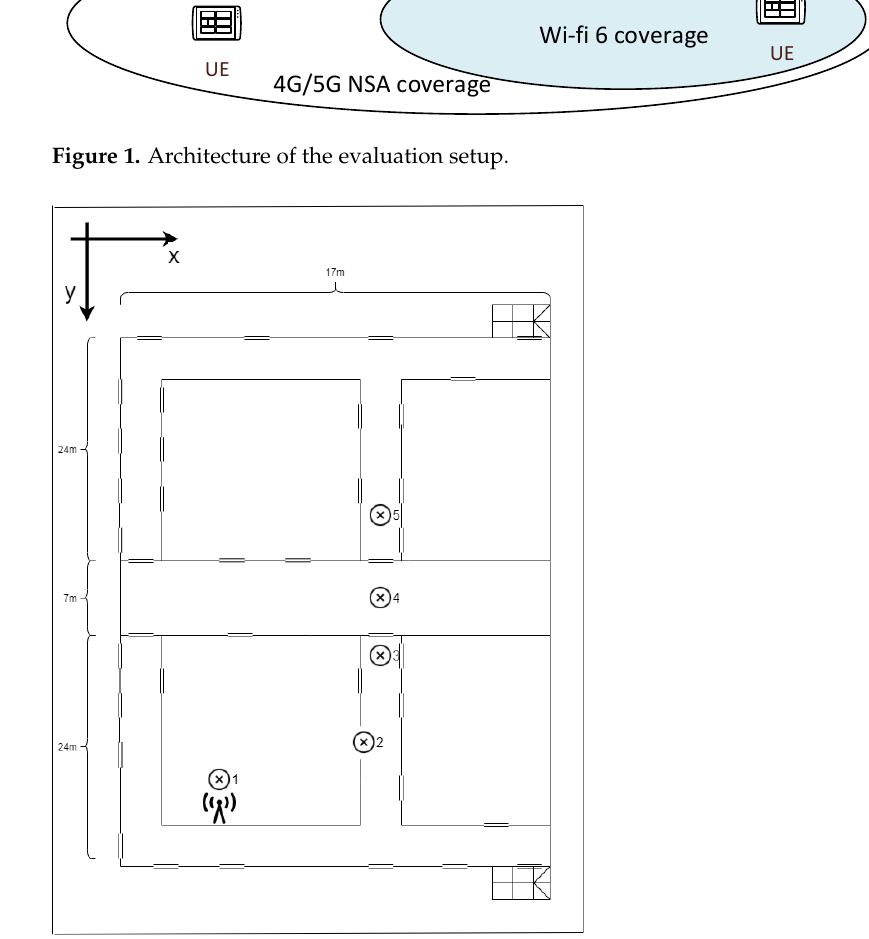
Figure 2. The measurement points presented on a map of VTT’s office building. Packet Inter Net Groper (PING) is a very simple transmission control protocol/Internet protocol (TCP/IP) utility [34]. Here, it is used to measure round trip time (RTT) between